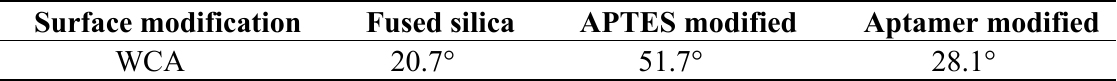
Table 1. Water contact angle measurement showing the different stages of surface modification from the bare substrate to SAM and immobilization of the